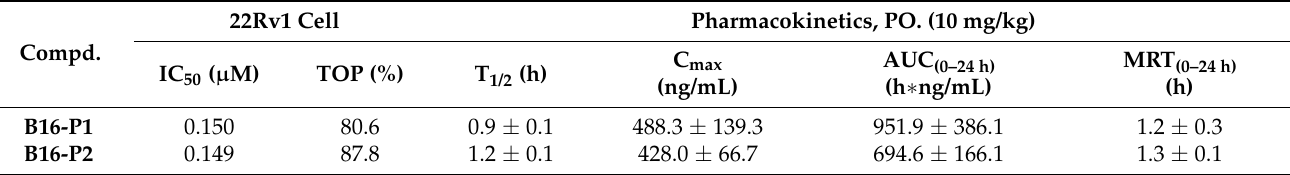
Table 4. 22Rv1 cell antiproliferation and pharmacokinetic profiles of two isomers of B16 a .